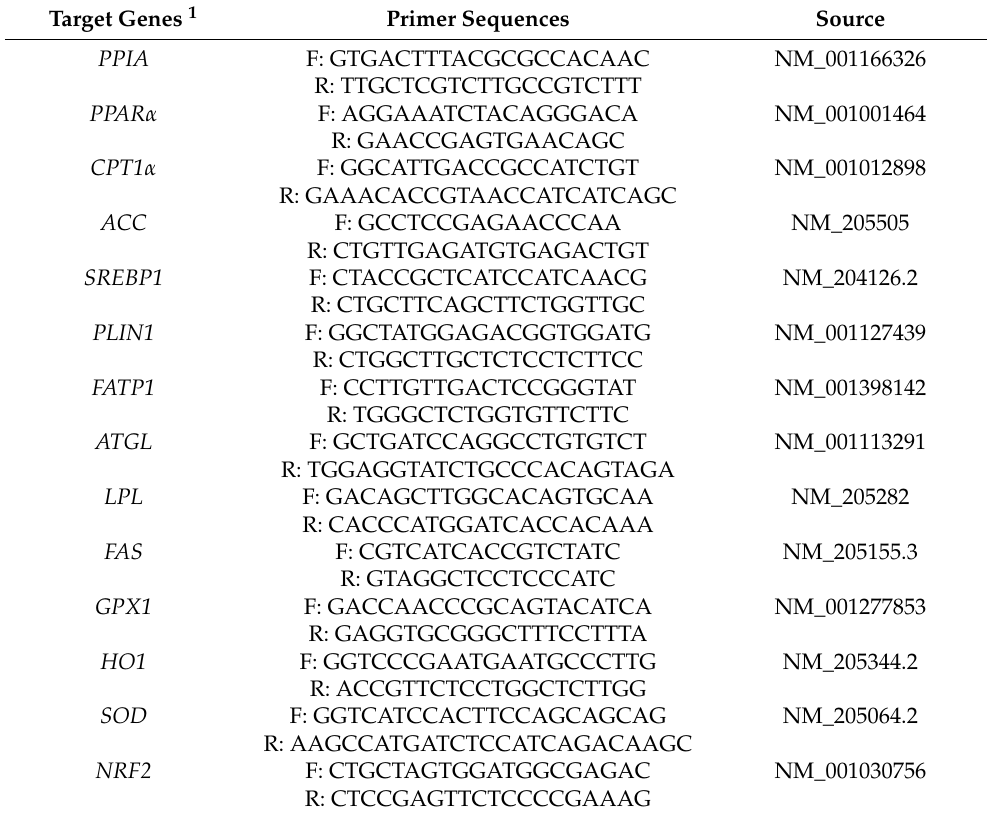
Table 2. The primer sequences for real-time